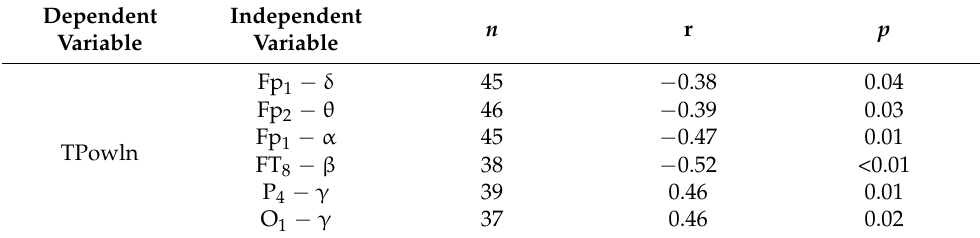
Table 9. Significant associations between electroencephalography variables and log transformed total heart rate variability power of train